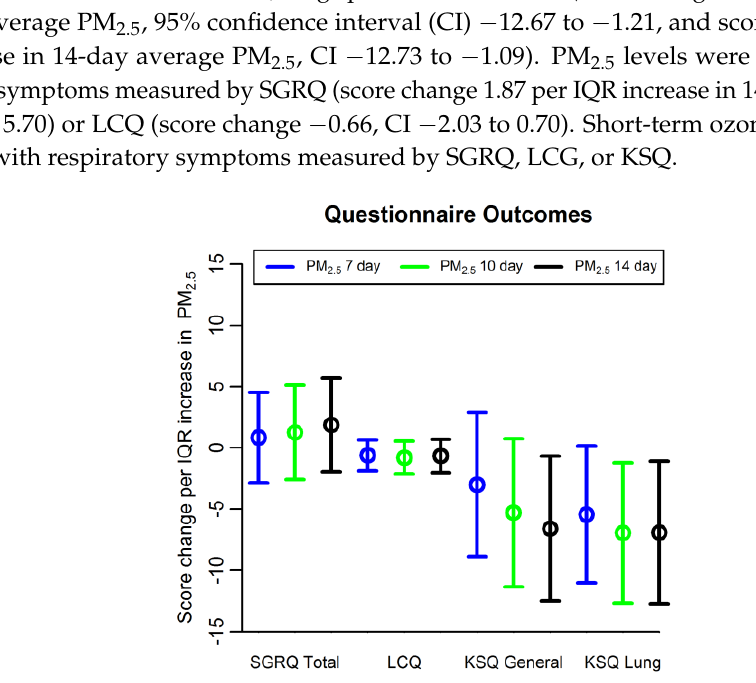
Figure 2. Association between PM 2.5 and questionnaire outcomes. Shown are questionnaire score changes per interquartile range (IQR) increase in PM 2.5 averaged over 7, 10, and 14 days. SGRQ = St. George’s Respiratory Questionnaire; LCQ = Leicester Cough Questionnaire; KSQ = King’s Sarcoidosis